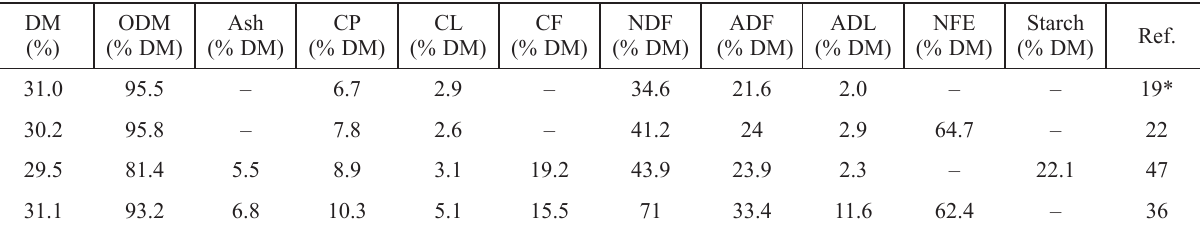
Table 1 – Literature data on characterization of maize silage DM (%)